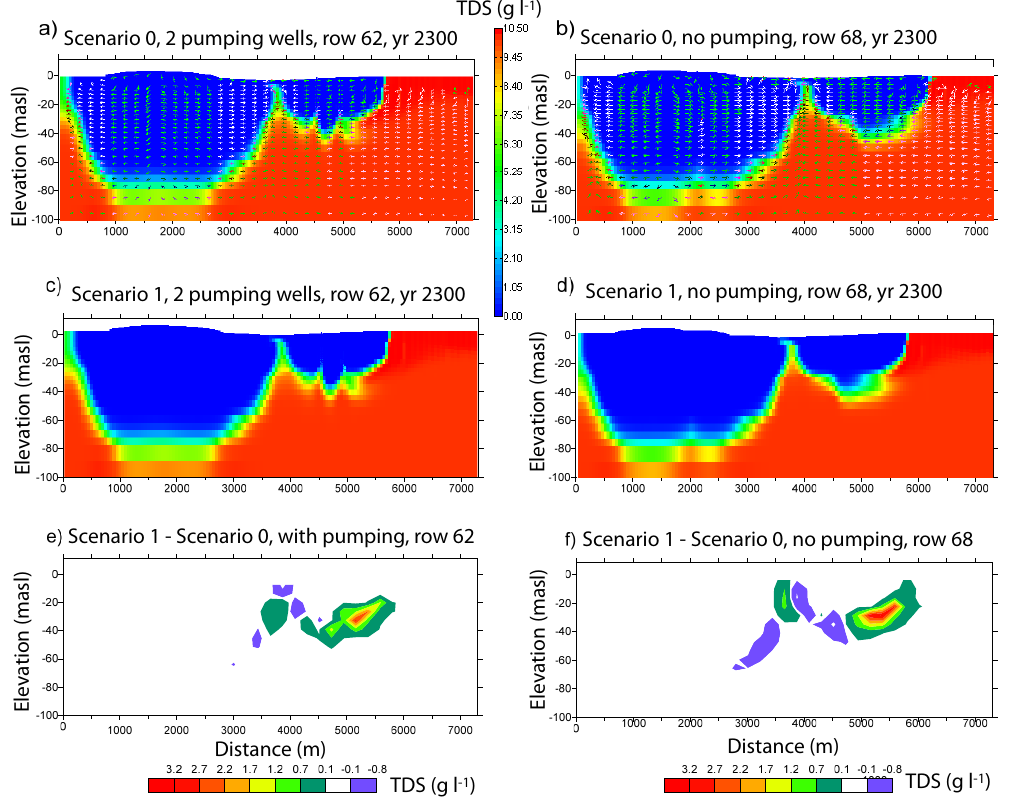
Fig. 12. Simulated freshwater-saltwater distribution in 2300 (scale TDS (gL − 1 ) ), (a) basic scenario 0, cross section with pumping wells and flow velocity vectors (row 62), (b) basic scenario 0, cross section with no pumping and flow velocity vectors (row 68), (c) reference scenario 1, cross section with pumping wells (row 62), (d) reference scenario 1, cross section with no pumping (row 68), (e) scenario 1– scenario 0, difference in TDS (mgL − 1 ), cross section with pumping wells (row 62), (f) scenario 1–scenario 0, difference in TDS (mgL − 1 ), cross section with no pumping (row